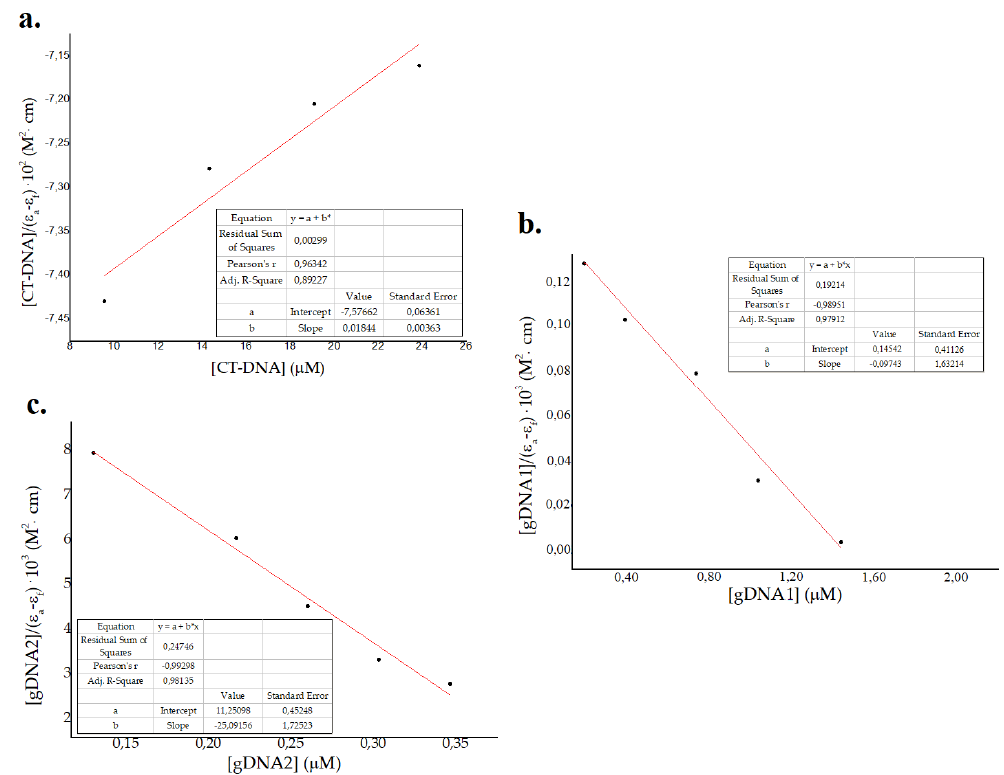
Figure 4. Wolf–Shimer plots for ( a ) eukaryotic calf thymus DNA (CT-DNA) and genomic DNA from ( b ) susceptible Pseudomonas aeruginosa ATCC 27853 (gDNA1) and ( c ) resistant Klebsiella pneumoniae ATCC 2146 (gDNA2).